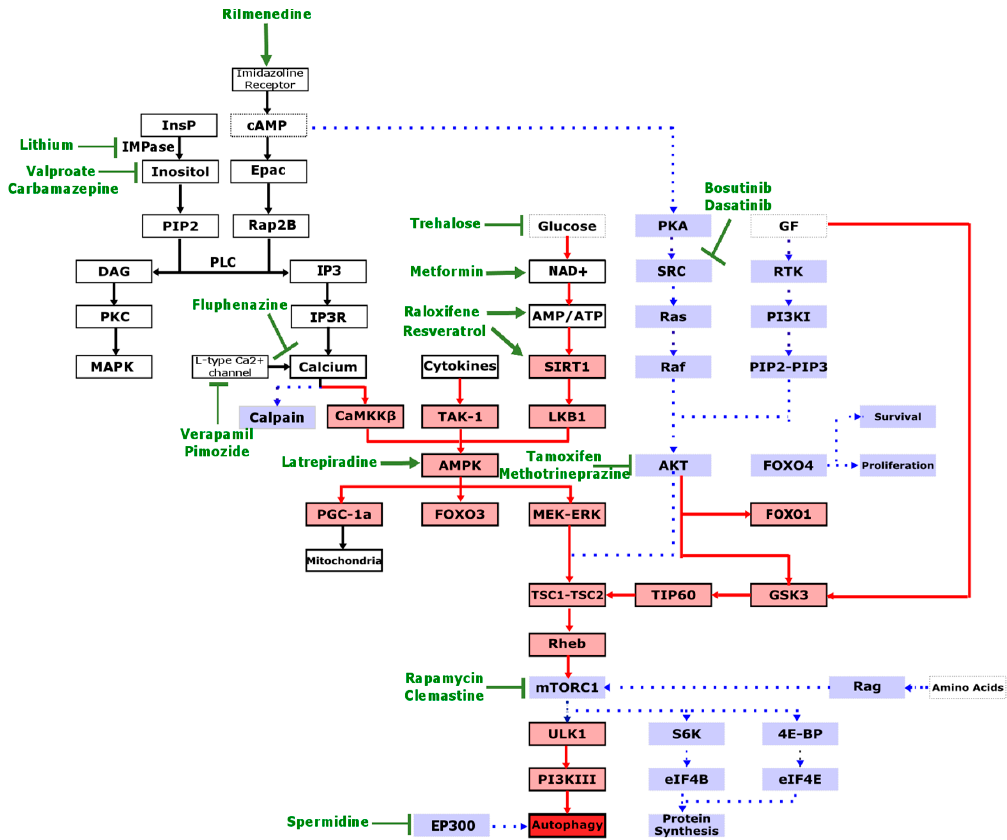
Figure 3. Autophagy-targeted treatments that have been studied in ALS. For autophagy to be activated, pathways depicted in red need to be upregulated and pathways depicted in blue need to be downregulated. The pathway that is targeted by the treatment is depicted in green (arrow if its effect is stimulatory and flathead if its effect is inhibitory). InsP, inositol phosphate; IMPase, inositol monophosphatase; PIP2, phosphatidylinositol 4,5- biphosphate; DAG, diacylglycerol; PKC, protein kinase C; MAPK, mitogen-activated protein kinase; cAMP, cyclic adenosine monophosphate; PLC, phospholipase C; IP3, inositol triphosphate; IP3R, inositol triphosphate receptor; CaMKK β , calcium/calmodulin-dependent protein kinase 2; TAK-1, transforming growth factor beta-activated kinase 1; NAD+, nicotinamide adenine dinucleotide; SIRT1, NAD-dependent deacetylate sirtuin-1; LKB1, liver kinase B1; PKA, protein kinase A; AKT/PKB, protein kinase B; GF, growth factor; FOXO4, forkhead box 4, FOXO1, forkhead box 1; GF, growth factors; RTK, receptor tyrosine kinase; PI3KI, class I phosphoinositol 3-kinase; PIP3, phosphatidylinositol-3,4,5-triphosphate; GSK3, glycogen synthase kinase 3; TIP60, tat-interactive protein 60 kDa; TSC1–TSC2, tuberous sclerosis complex; Rheb, Ras homolog enriched in brain; mTORC1, mammalian target of rapamycin complex I; ULK1, Unc-51 like autophagy activating kinase 1; PI3KIII, class III phosphoinositol 3-kinase; S6K, ribosomal protein S6 kinase beta-1; 4E-BP, eukaryotic translation initiation factor 4E-binding protein 1; eIF4E, eukaryotic translation initiation factor 4E; EP300, E1A binding protein P300.